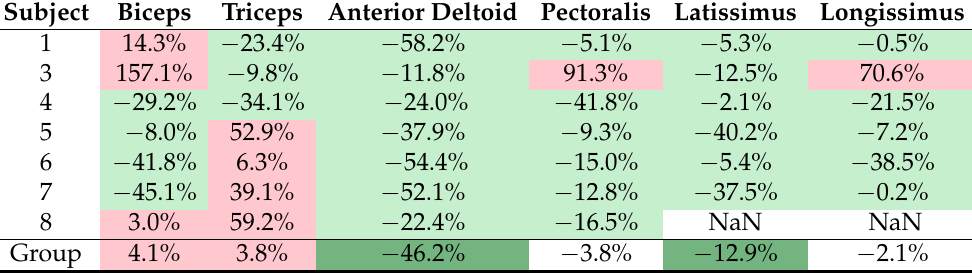
Table 1. Difference in muscle solicitation between the two conditions for all participants. The light green cells indicate a non-significant decrease in muscle activity with the exoskeleton, the dark green cells indicate a significant decrease, and the red cells show a non significant